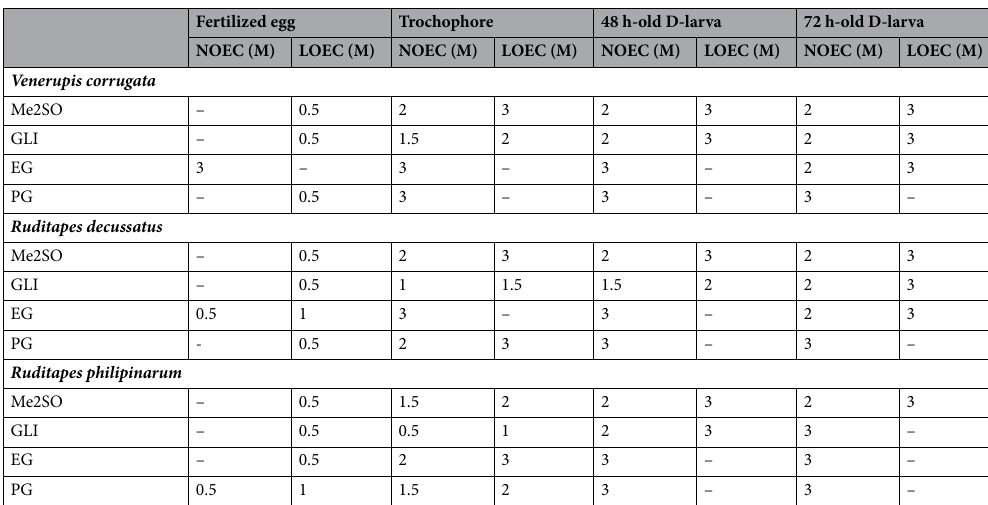
Table 1. NOEC (no observed effect concentration) and LOEC (lowest observed effect concentration) levels (mol/L) for development stages (fertilized egg, trochophore, 48 and 72 h-old D-larva) of Venerupis corrugata, Ruditapes decussatus and Ruditapes philippinarum after exposure to increasing concentrations of the following cryoprotecting agents (CPAs): ethylene–glycol (EG), propylene–glycol (PG), dymethil-sulfoxide (Me 2 SO) and glycerol (GLY)